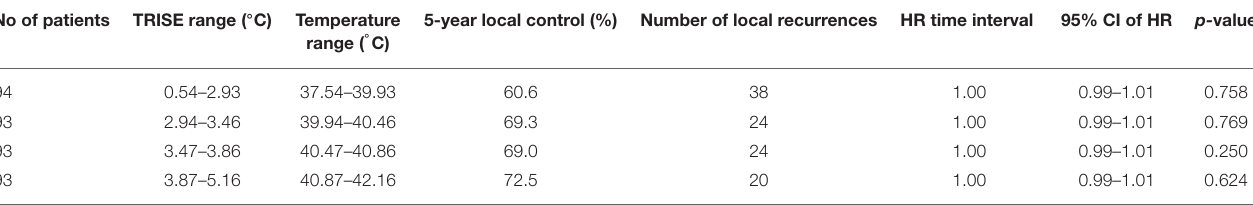
TABLE 1 | Analysis of the effect of the time interval using univariate Cox analysis in patients groups divided over the quartiles of TRISE. No of patients TRISE range ( ◦ C) Temperature range ( ◦